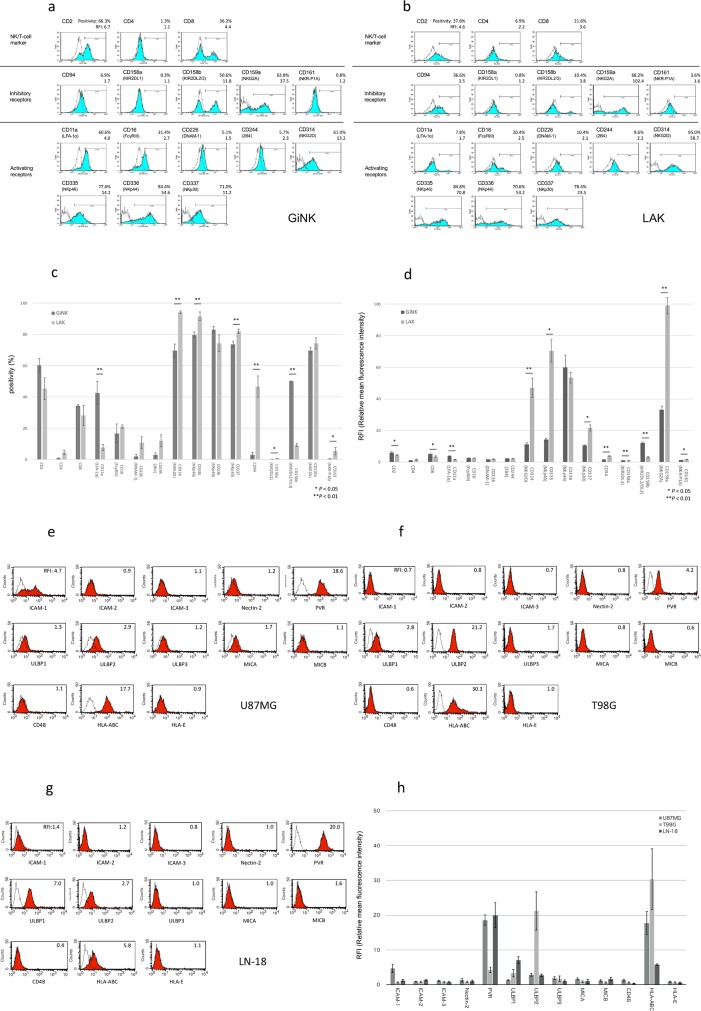
Analysis of the surface receptors’ expression on GiNK and ligands’ expression on GBM cell lines specific for receptors expressed on GiNK.(a, b) Representative data of receptor expression on GiNK (a) and LAK (b). Cells were stained with specific mAbs and analyzed using flow cytometry. Open dot line histograms, with controls stained with isotype mAb; filled histograms, specific mAb staining. Top, middle, and bottom panels show representative NK/T-cell markers, activating NK receptors, and inhibitory NK receptors, respectively. The positivity indicates the percentage of positive cells. The relative mean fluorescent intensity (RFI) divided by the overall mean fluorescence intensity of each sample from the isotype control. (c) The positivity of the surface receptor expressing cells in GiNK and LAK. The numbers given are the average of positivity obtained from three independent experiments. P values were determined using a t-test or Mann–Whitney U test: *P < 0.05, **P < 0.01. (d) The RFI of the surface receptor expression on GiNK and LAK. The numbers given are the average RFI of values obtained from three independent experiments. P values were determined using a t-test or Mann–Whitney U test: *P < 0.05, **P < 0.01. (e, f, g) Representative data of ligands expressed on GBM cell lines U87MG (e), T98G (f), LN-18 (g) specific to the receptors on NK cells. Open dot line histograms, controls stained with isotype mAb; filled histograms, specific mAb staining. The RFI divided by the overall mean fluorescence intensity of the individual sample from isotype-matched control. (h) The RFI of ligands expressed on GBM cell lines specific to the receptors on GiNK. Each bar shows the mean ± SE of values obtained from triplicate experiments.